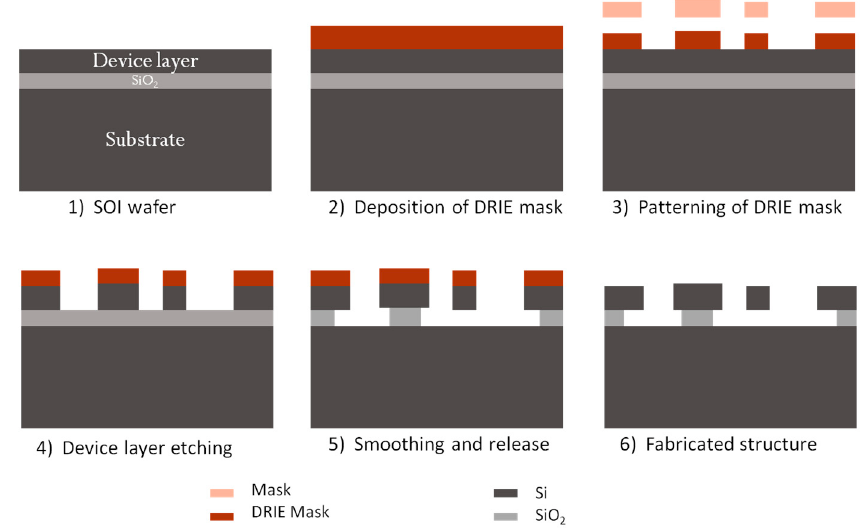
Figure 7. The main fabrication steps of the MEMS spectrometer.